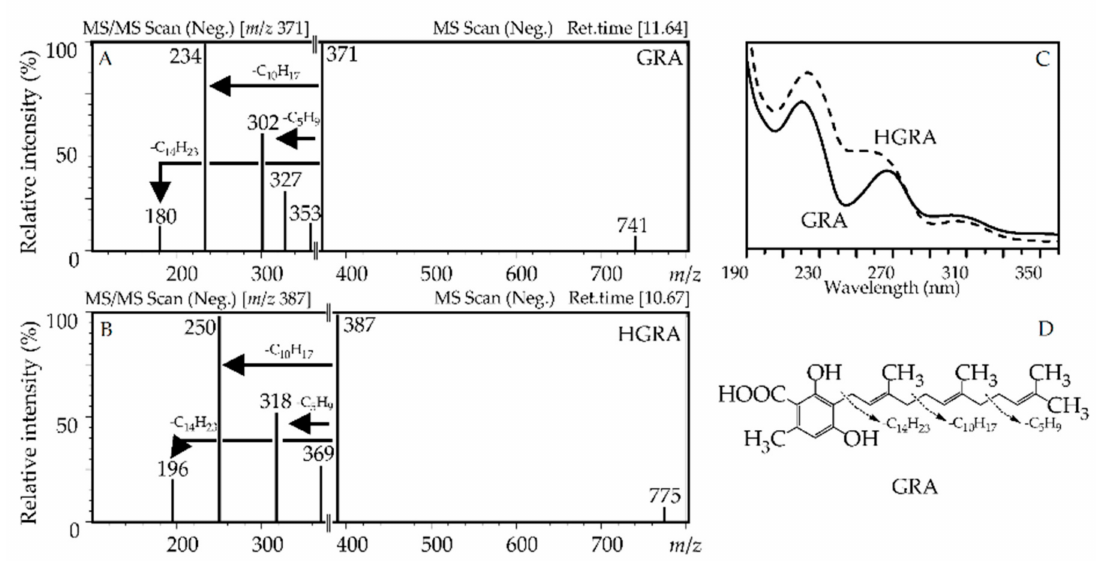
Figure 7. Mass spectra ( A , B ); negative ionization), UV patterns ( C ) of grifolic acid (GRA) and hydroxy-grifolic acid (HGRA), and fragmentation way of GRA ( D ).